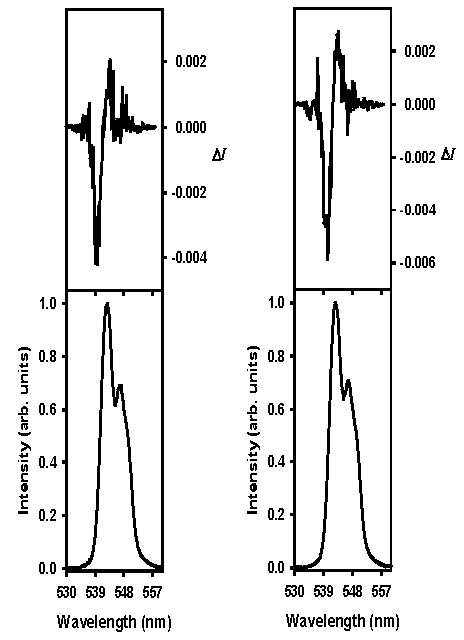
Figure 6. Circularly polarized luminescence (CPL) (top curves) and luminescence (lower curves) spectra for the 5 D 4 → 7 F 5 transition of [Tb(DPA) 3 ] 3 − with 40 equiv. L -serine for 100:0 H 2 O ( left ) and 90:10 H 2 O:THF ( right ).